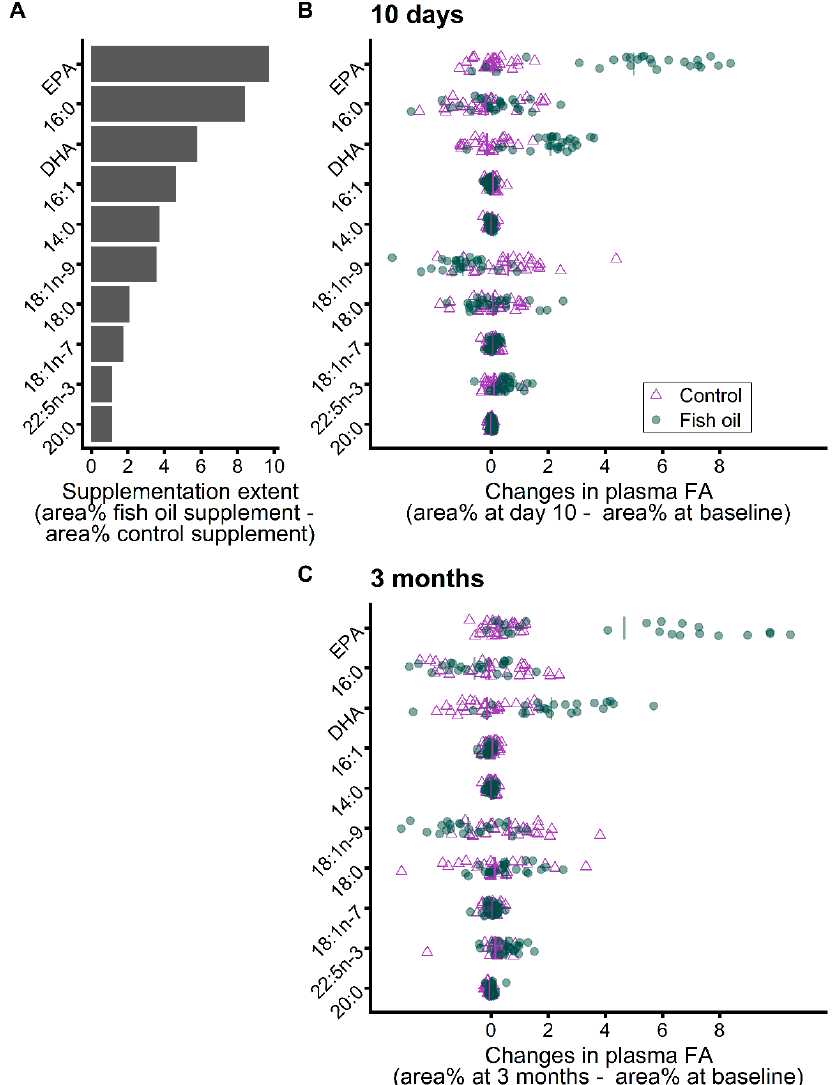
Figure 3. ( A ) Difference between the fatty acid compositions of the fish oil and control supplements (based on fatty acid profiles of supplements (Table S1): fatty acid area% in the fish oil supplement– fatty acid area% in the control supplement). ( B ) Early changes in plasma fatty acid proportions that occurred 10 days after supplementation onset. ( C ) Later changes in plasma fatty acid proportions that occurred 3 months after supplementation onset. Lines represent group averages. Values are sorted according to differences between supplements in fatty acid compositions and only presented for fatty acids with a difference between supplements >1 area%. EPA, eicosapentaenoic acid (20:5n-3); DHA, docosahexaenoic acid